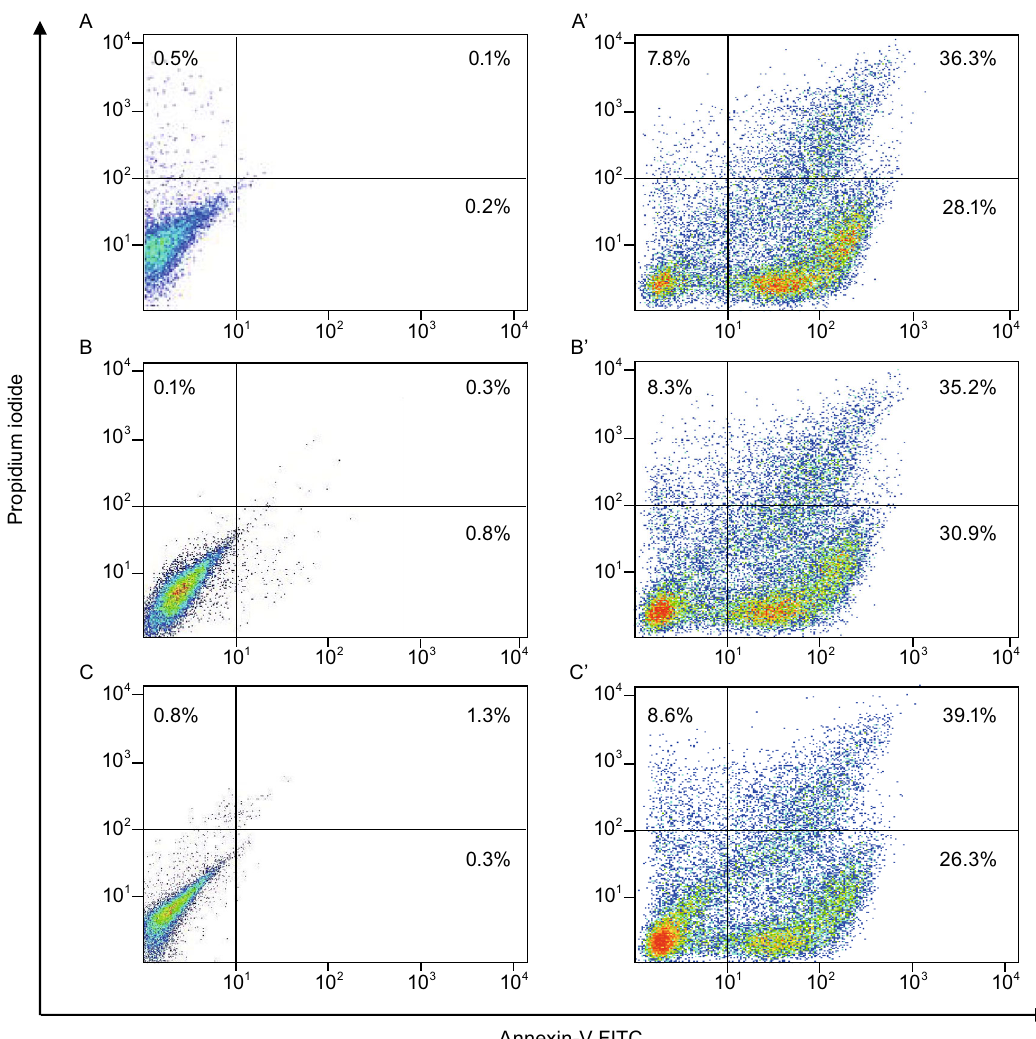
Figure 4. SGIV causes medaka cell apoptosis. HX1, GFP-HX1and 88GFP-HX1cells at 48 hpi with SGIV were stained